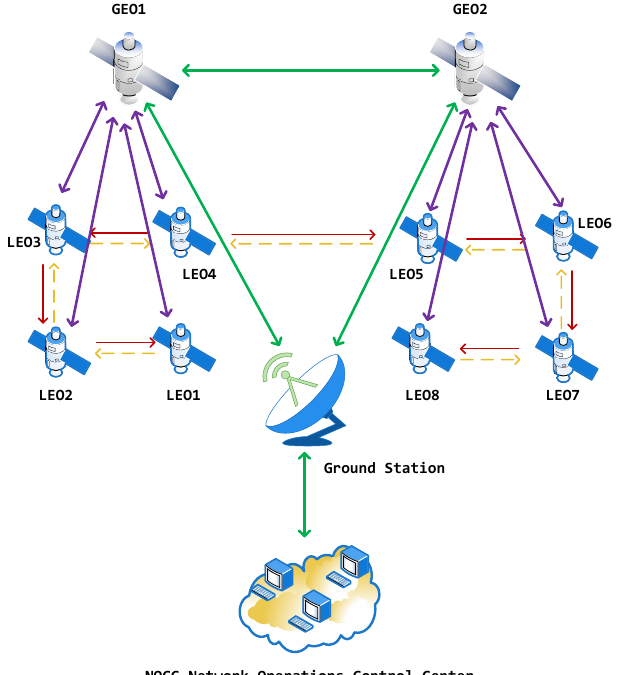
Figure 2. Satellite network resource management architecture diagram graph.